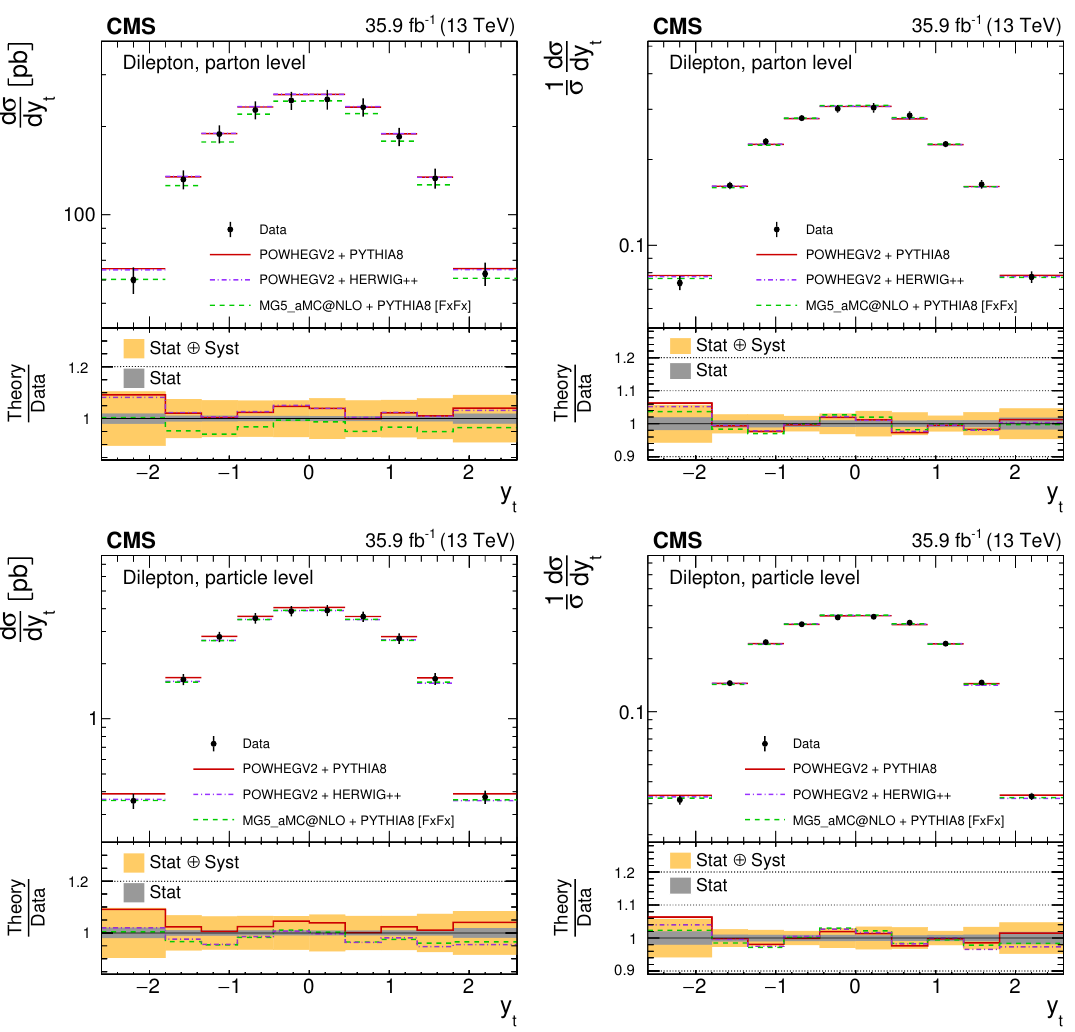
Figure 12 . The di(cid:11)erential tt production cross sections as a function of y t are shown for the data (points) and the MC predictions (lines). The vertical lines on the points indicate the total uncertainty in the data. The left and right columns correspond to absolute and normalised mea- surements, respectively. The upper row corresponds to measurements at the parton level in the full phase space and the lower row to the particle level in a (cid:12)ducial phase space. The lower panel in each plot shows the ratios of the theoretical predictions to the data. The dark and light bands show the relative statistical and total uncertainties in the data, respectively.